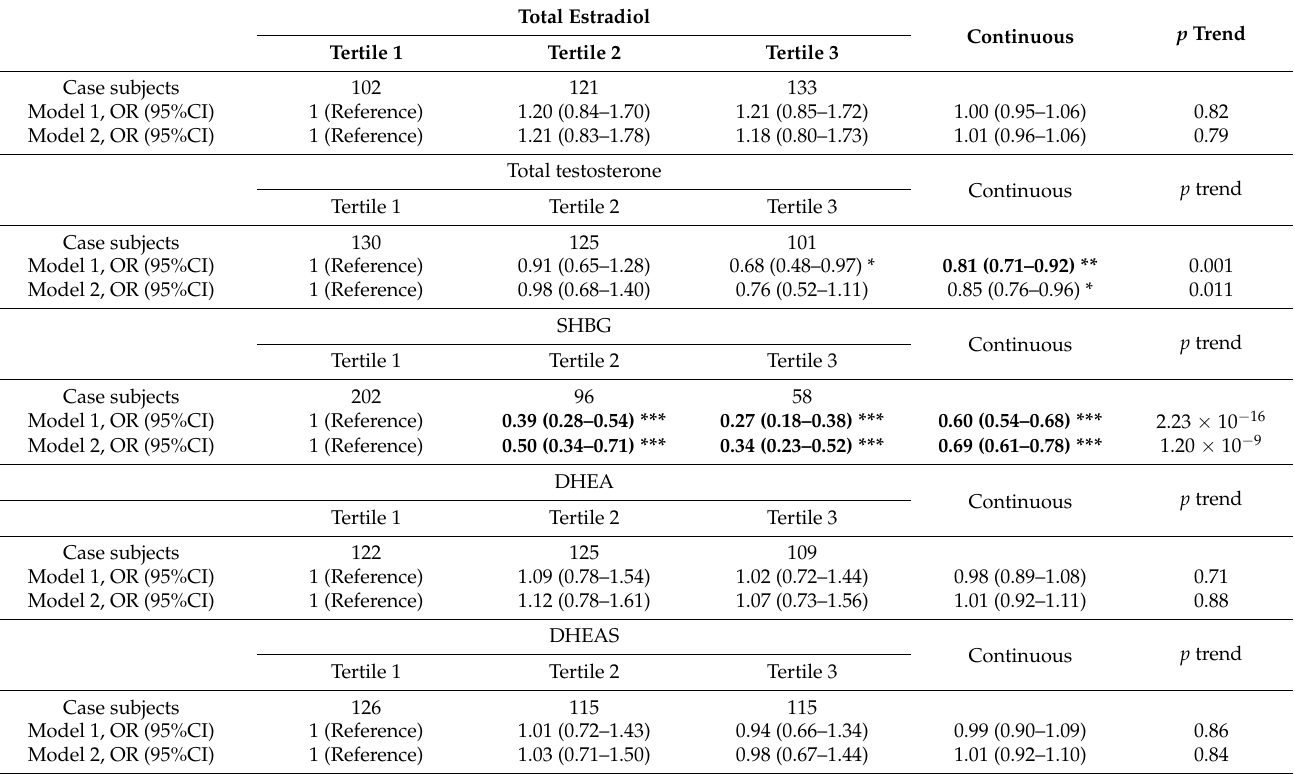
Table 3. Associations of sex steroids and SHBG with NAFLD among women. Total